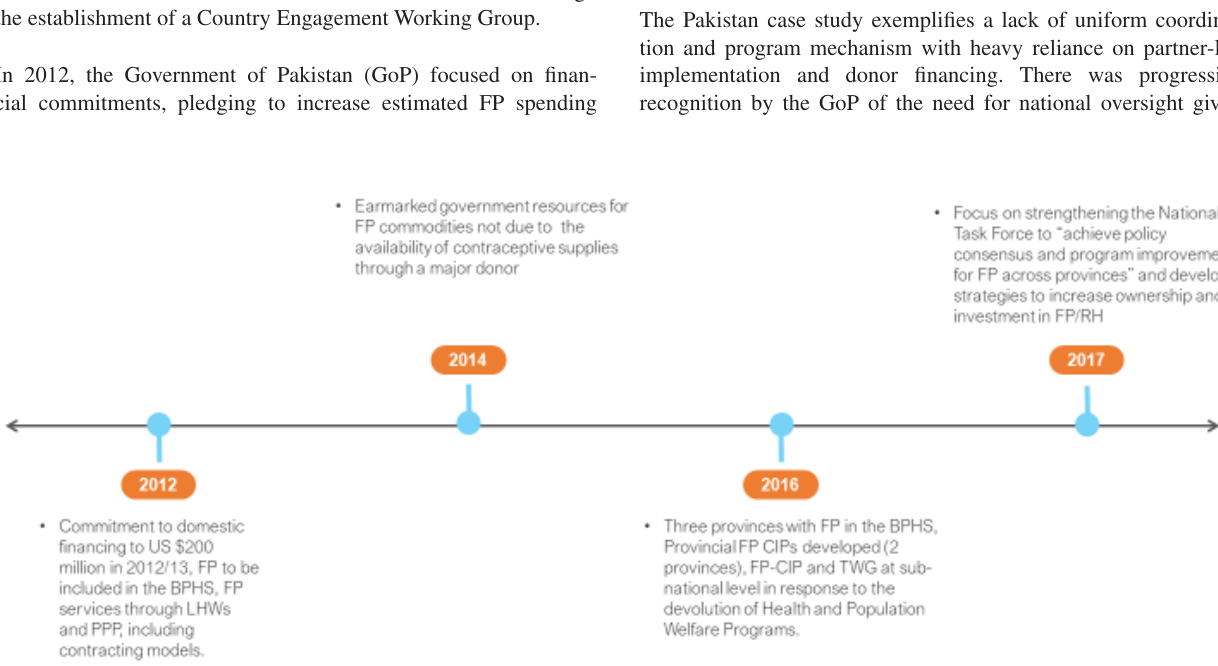
Figure 4. Pakistan FP2020 commitments and timeline. BPHS – basic package of health services; CIP – costed implementation plan; TWG – technical working group; FP/RH – family planning/reproductive